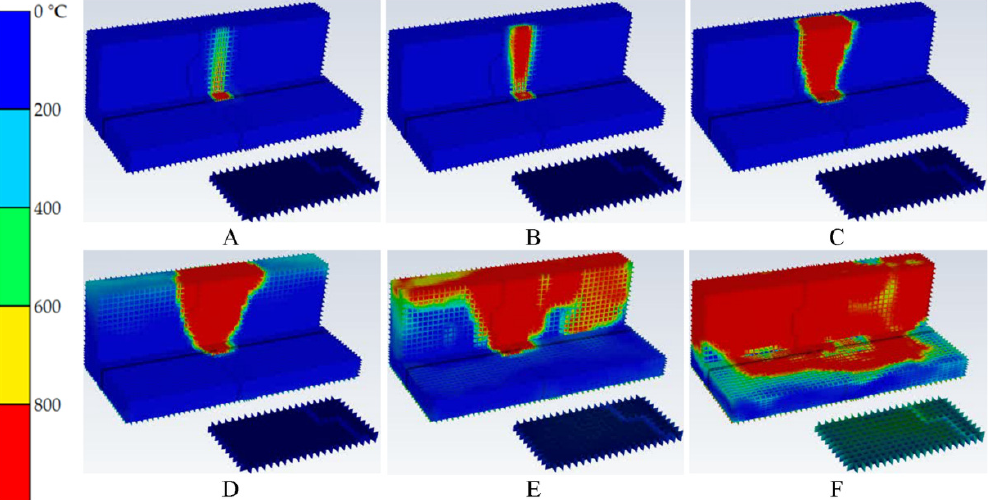
Figure 12. The subsequent phases of sofa fire development: temperature distribution on its surface (description in text).